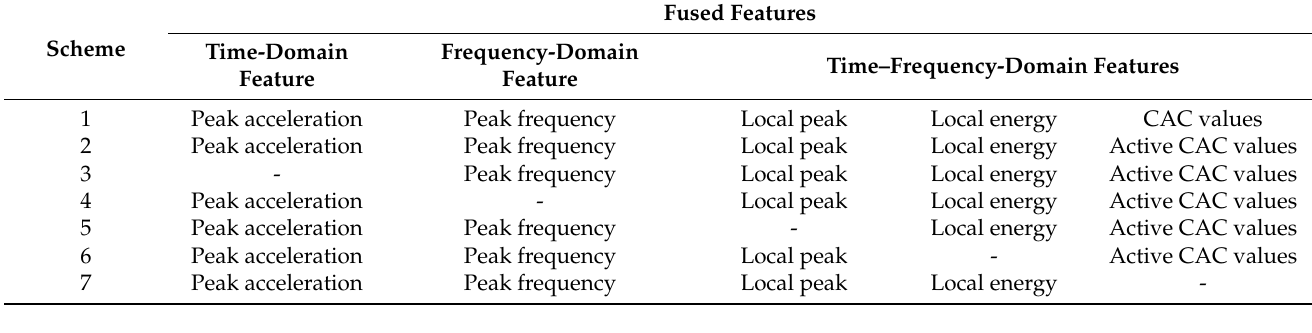
Table 8. Fusion schemes.